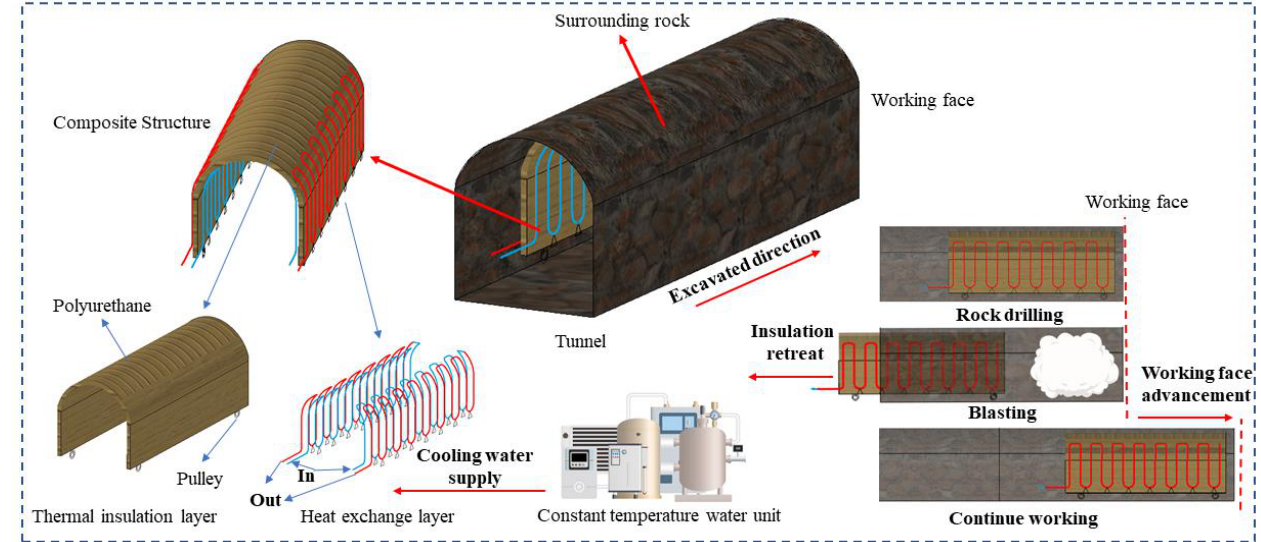
Figure 1. Movable thermal insulation layer structure and partial insulation method.